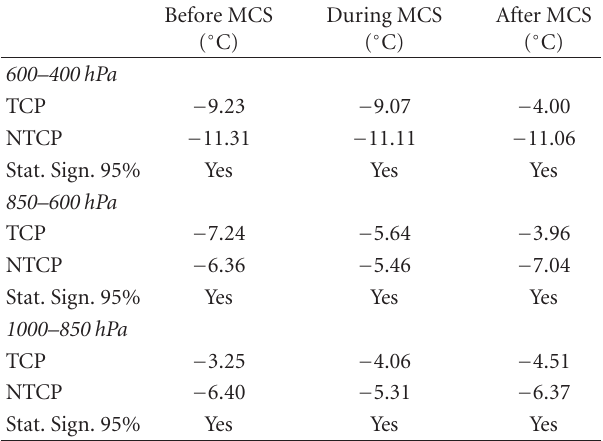
Table 3: Mean dewpoint depression at three levels (1000–850 hPa, 850–600 hPa, and 600–400 hPa) for mean soundings prior to, during, and after MCS progression through the domain for each case type. Statistical significance of these values at 95% based on a student’s t -test is also indicated.